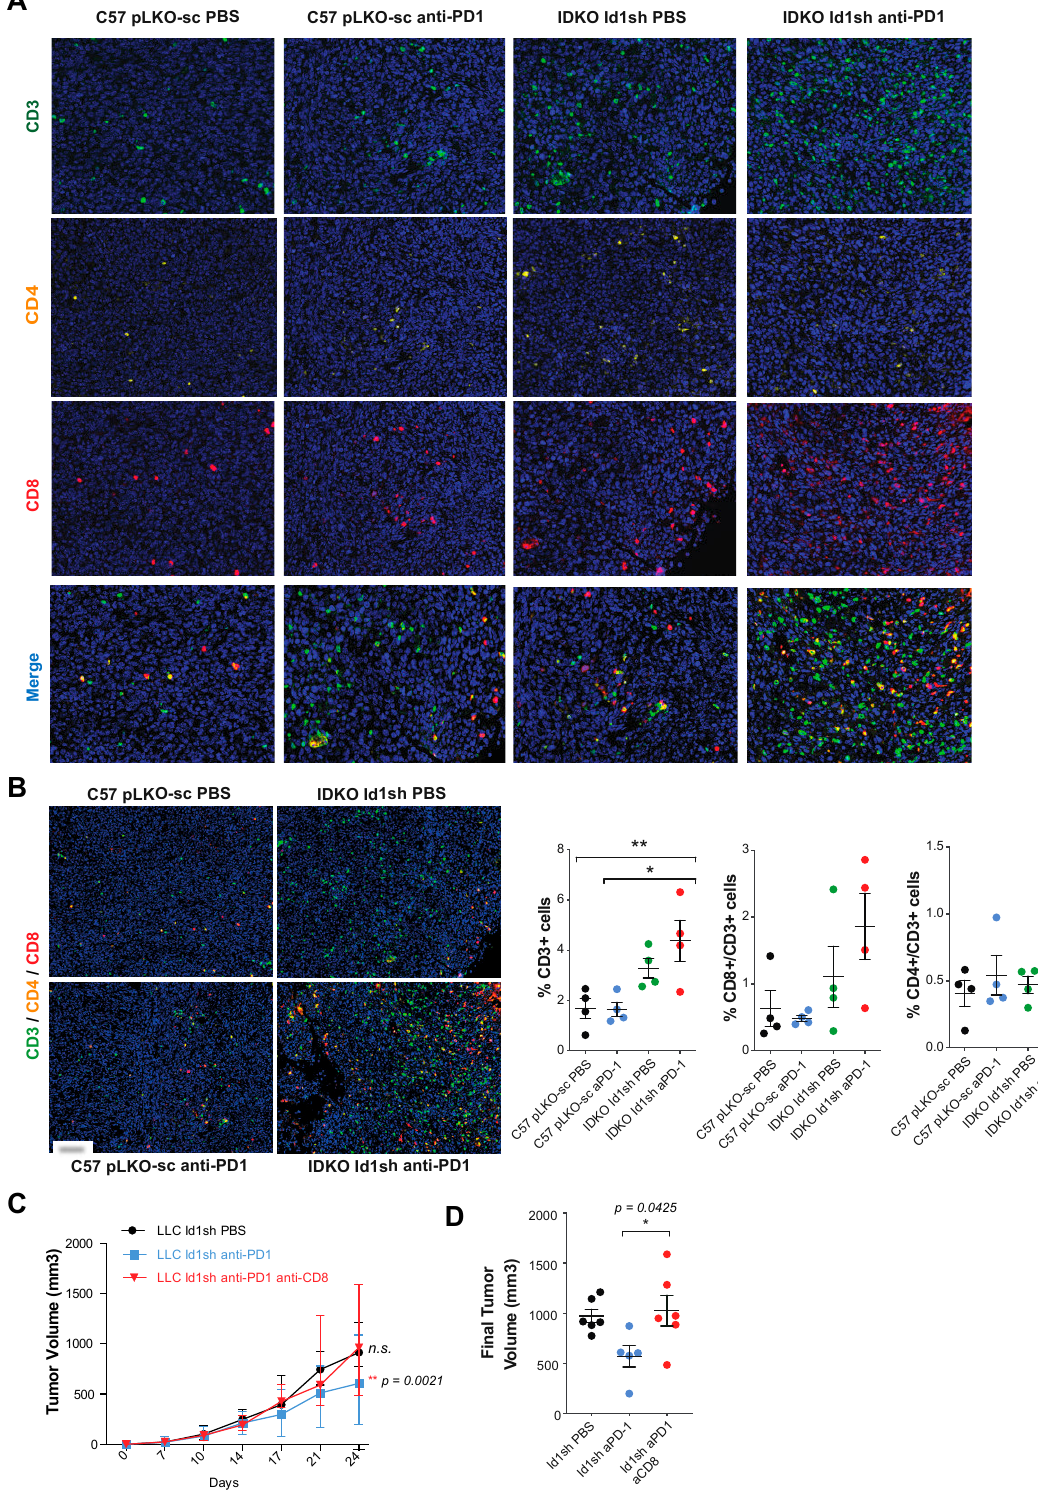
Figure 5. CD8 + T cells inflammatory infiltrate may mediate the anti-tumor activity observed after the Id1 and PD-1 blockade. ( A ) Quantitative multiplex IHC (CD3, CD4, CD8 and multiplex) in representative sections of tumors belonging to group of mice with extreme phenotypes [Id1 +/+ / DPBS (pLKO-sc LLC), Id1 +/+ / anti-PD-1 (pLKO-sc LLC), Id1 - / - / DPBS (Id1sh LLC) and Id1 - / - / anti-PD-1 (Id1sh LLC); four mice per group]. ( B ) Representative merged images derived from the multiplex quantification of CD3/CD4/CD8 in the same tumors as in A confirm the higher TIL when tumors lack Id1 and are treated with anti-PD-1 therapy. Quantification of the percentage of CD3, CD8/CD3, and